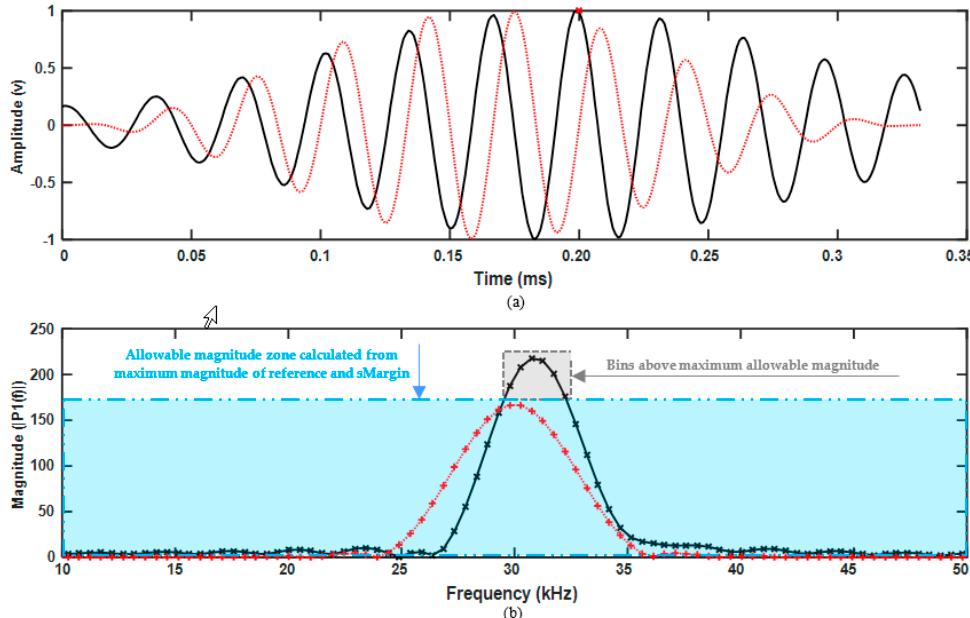
Figure 10. Example of an outlier case detected using Condition Four (C4), where ( a ) shows the time domain of the iteration window and ( b ) is its respective power spectrum. The red lines (dotted, +) show the references achieved from excitation sequence and the black lines (solid, x) show the results from each iteration.